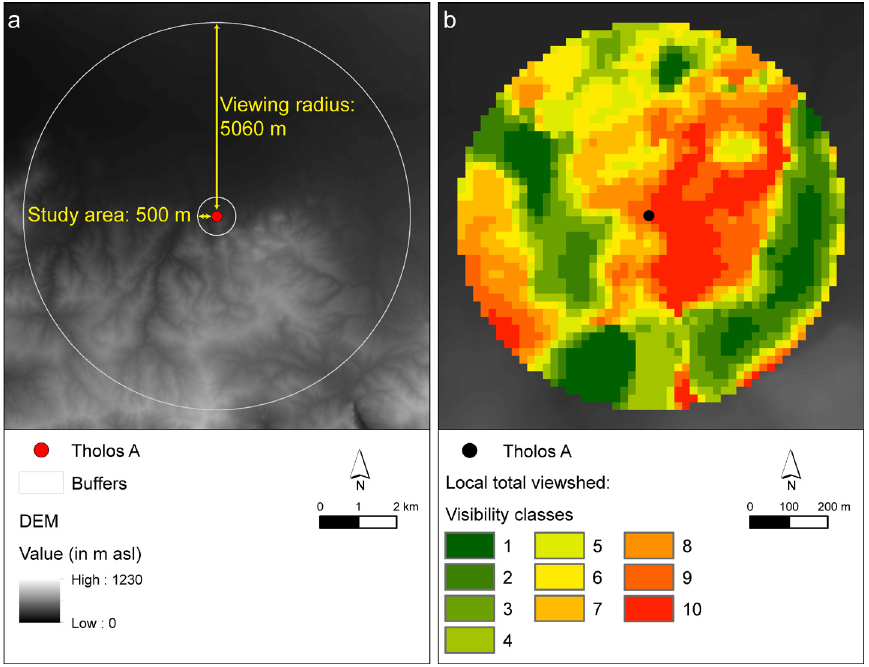
Figure 7. Local total viewshed of Tholos A at Apesokari: a) study area and maximum viewing radius; b) local total viewshed classified into